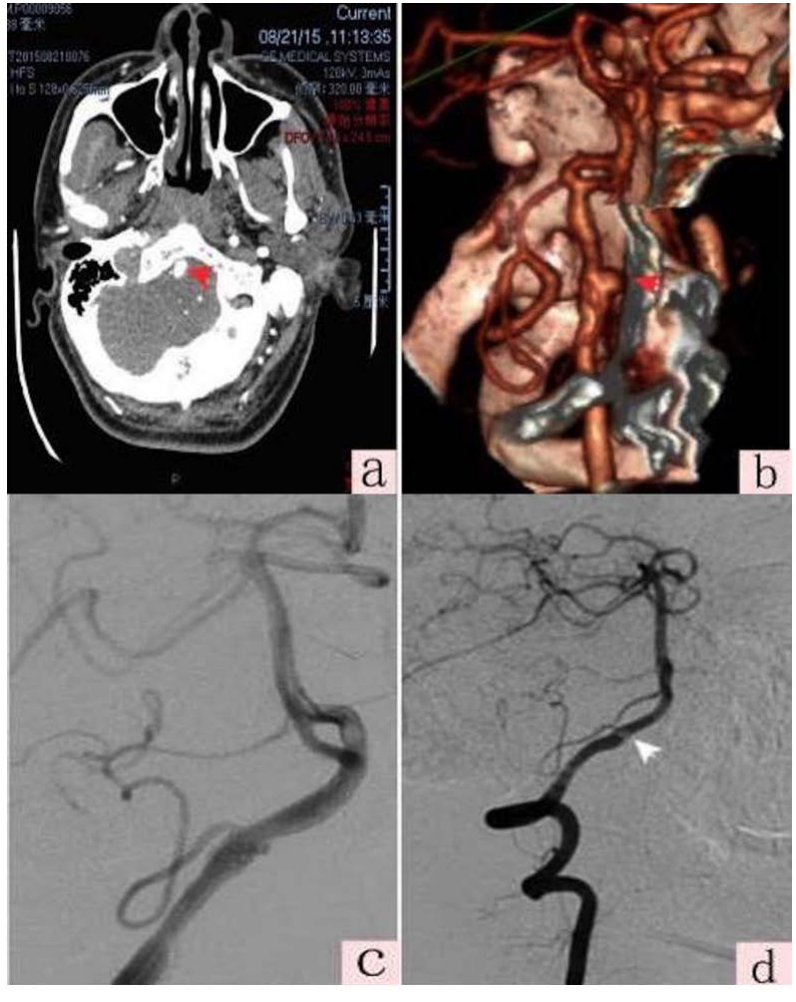
Figure 2. Right vertebral artery V4 segment dissection aneurysm treated with LVIS stent- assisted coil embolization: a. Cranial CTA showing the double-chamber sign; b. Head CTA reconstruction image shows the right vertebral artery and the posterior inferior cere- bellar artery with a contralateral aneurysm accompanied by distal vertebral artery steno- sis; c. cerebral vascular contrast imaging 6 months after embolization; d. Cerebral angiog- raphy showing not recurrence of dissection of the aneurysm one year after the procedure. No vessel stenosis and no posterior inferior cerebellum infarction. Note: red arrows show coils in the aneurysmal sac while white arrow show patency of diseased